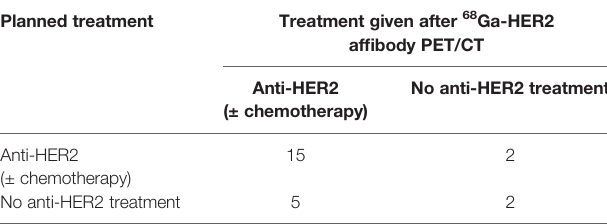
TABLE 2 | Treatment decision changes before and after 68 Ga-HER2 af fi body PET/CT. Planned treatment Treatment given after 68